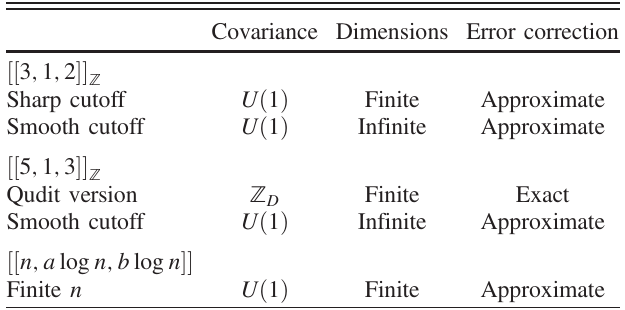
TABLE I. Summary of the codes considered in Sec. VI: the three-rotor secret-sharing code, the five-rotor perfect code, and an n -qubit “ thermodynamic code ” with code words consisting of Dicke states (and a , b chosen